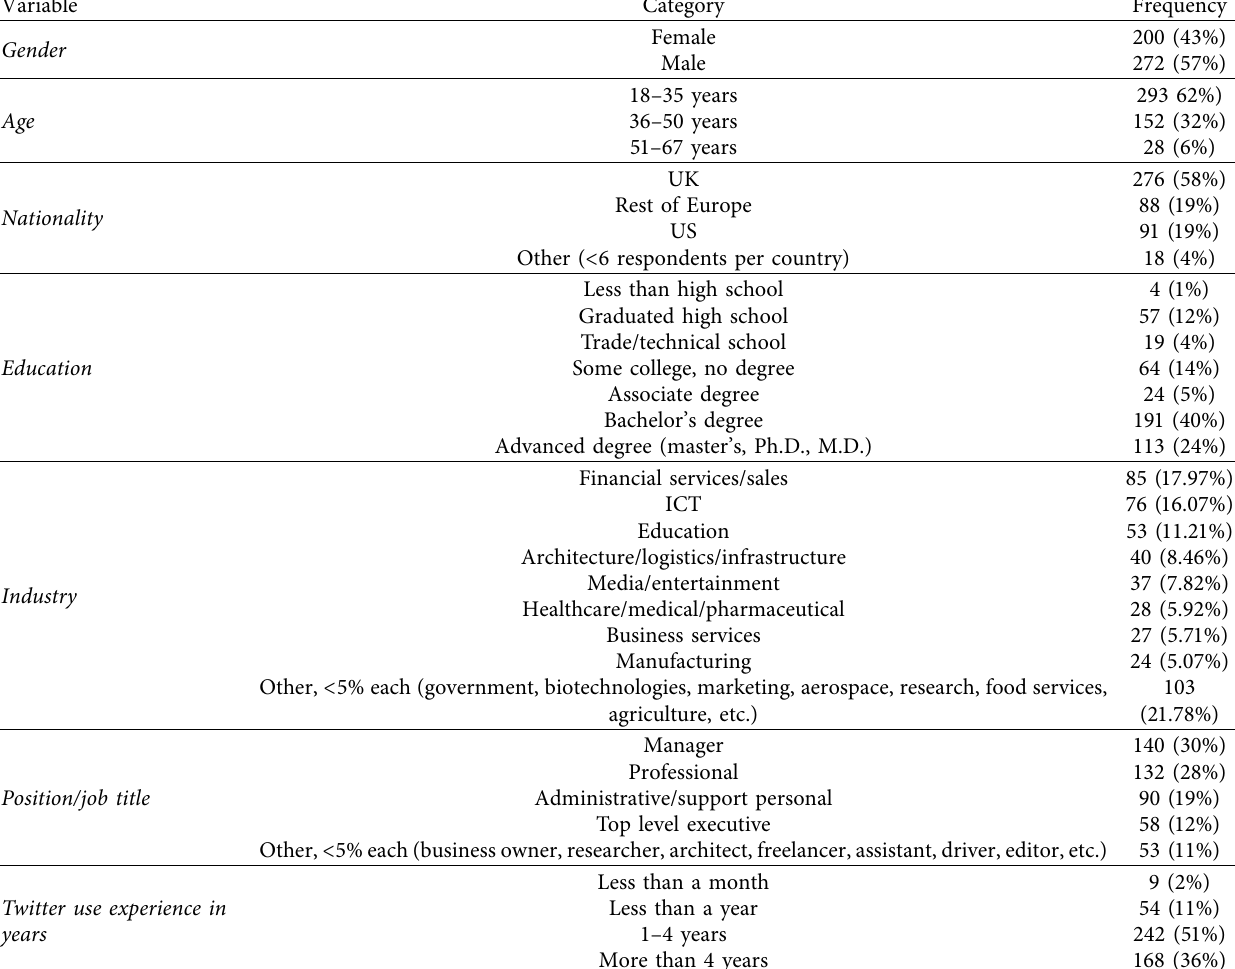
Table 1: Sample characteristics ( N �